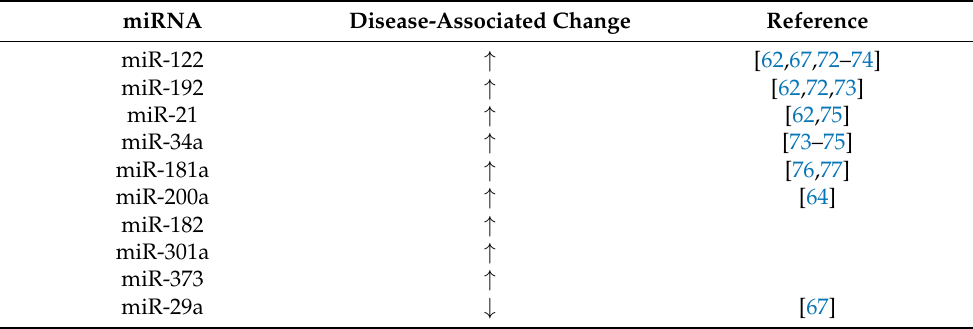
↑ and ↓ arrows designate upregulation and downregulation,